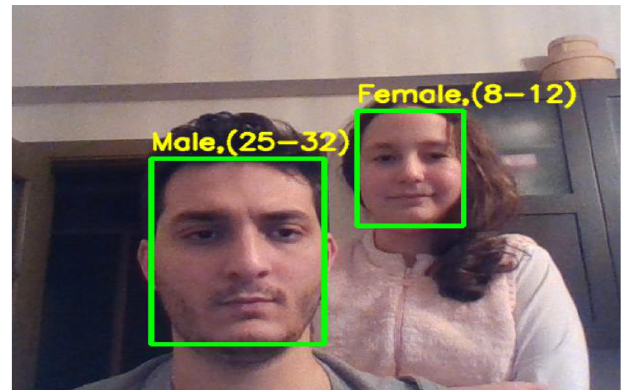
Fig. 11. Age and gender classification of a young man and a girl.